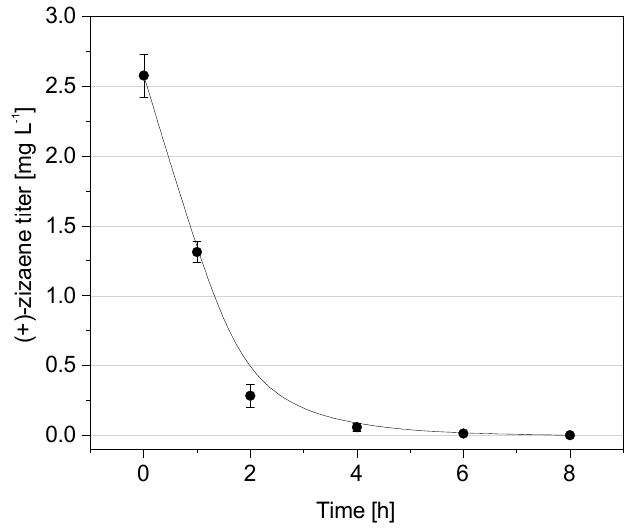
Figure 2. Loss of (+)-zizaene by volatilization on cell-free media at shake flask scale. Data are the mean of three replicates with error bars representing the standard deviation (SD).